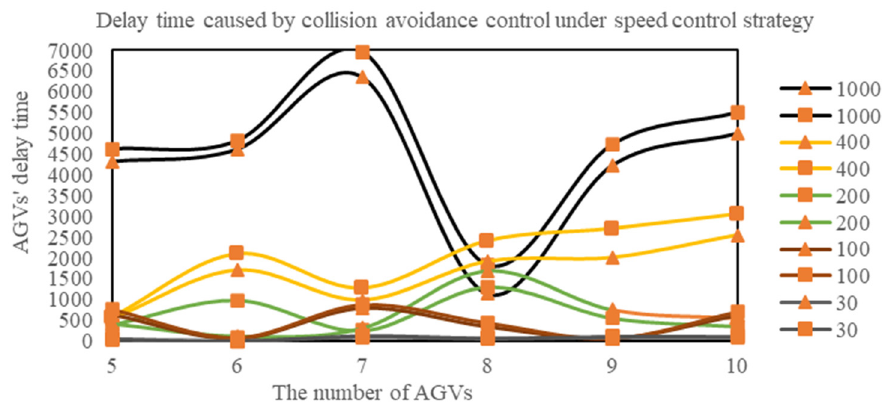
Figure 10. Delay time of collision avoidance control with/without collision avoidance.